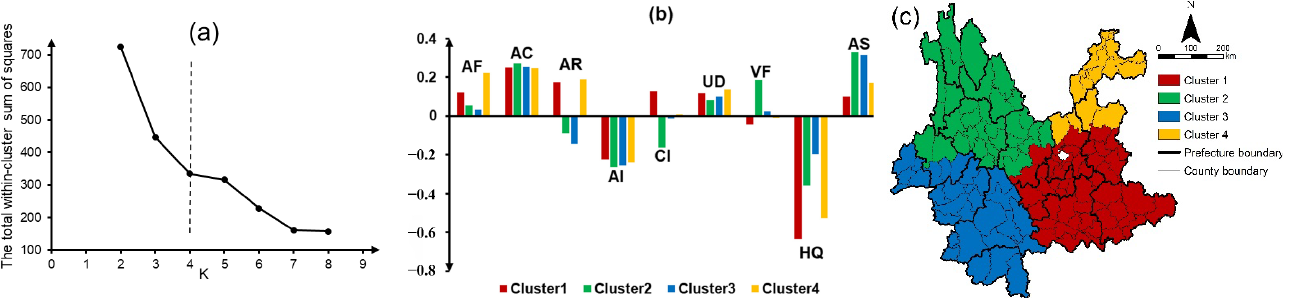
Figure 9. Clustering results in TPA: ( a ) optimal clustering number, ( b ) column chart of LUT factors regression coefficient, and ( c ) spatial patter n .